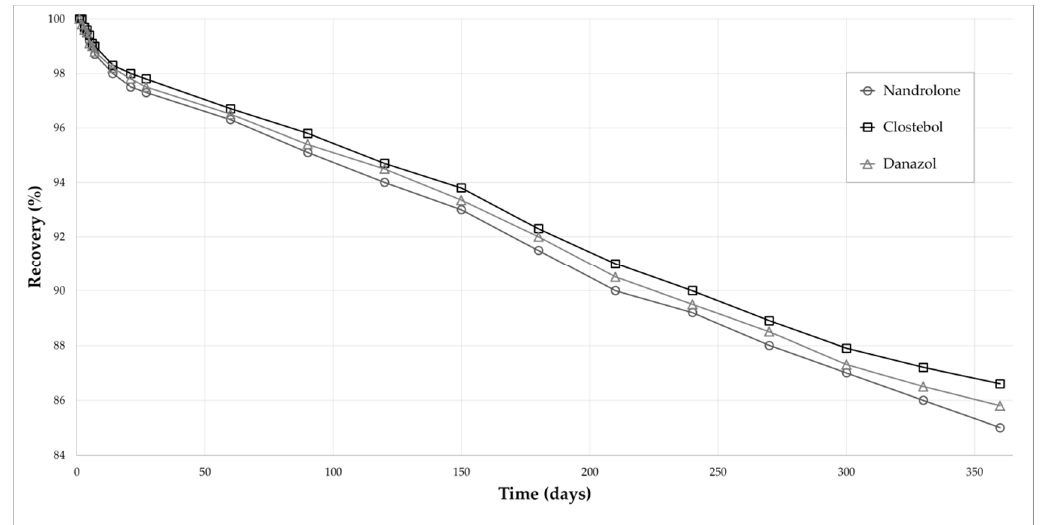
Figure 2. Stability results from blank spiked urine VAMS stored at RT.